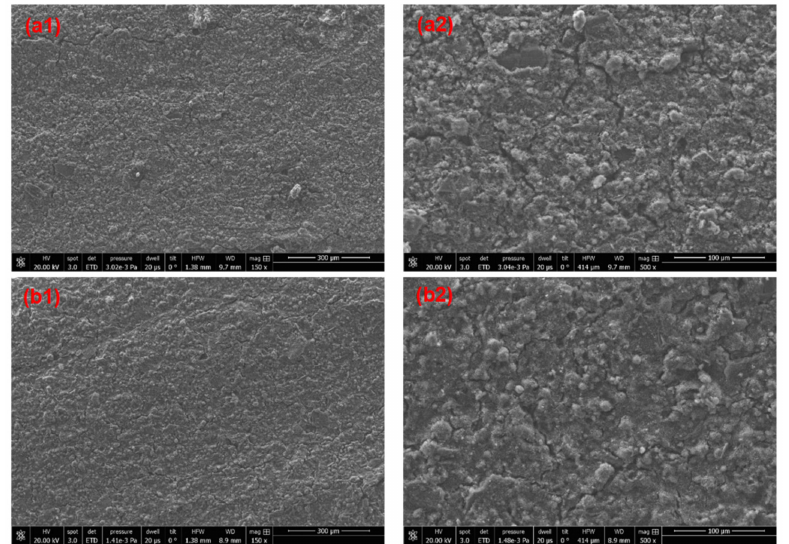
Figure 11. SEM micrographs of the surfaces of the silicate coatings SW1 and SW2 before ( a1 , b1 ) and SW2 ( a2 , b2 ) after exposure to